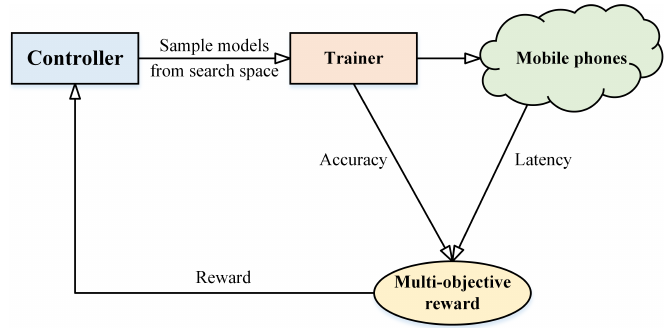
Figure 37. An Overview of Platform-Aware NAS for